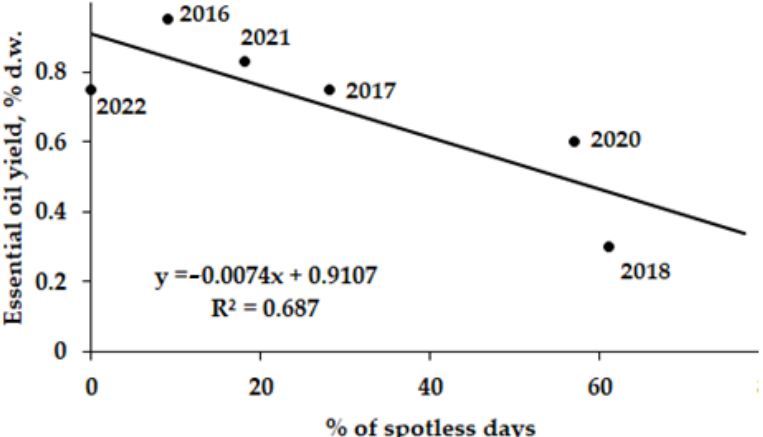
Figure 4. Number of oil components in A. annua leaves from 2016 to 2022 (r = 0.996; p < 0.0001).